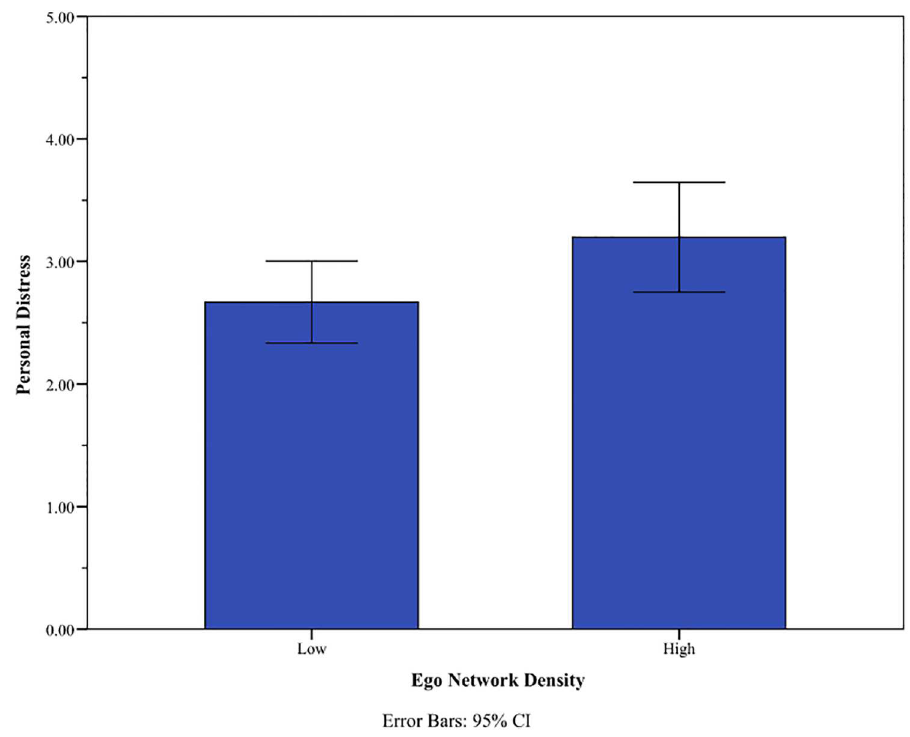
Fig 9. Personal distress and network density. The mean responseof the PersonalDistress scale of IRI is reported. N = 35 (the number of observations for low density is 22 whereasthat for high density is 13).